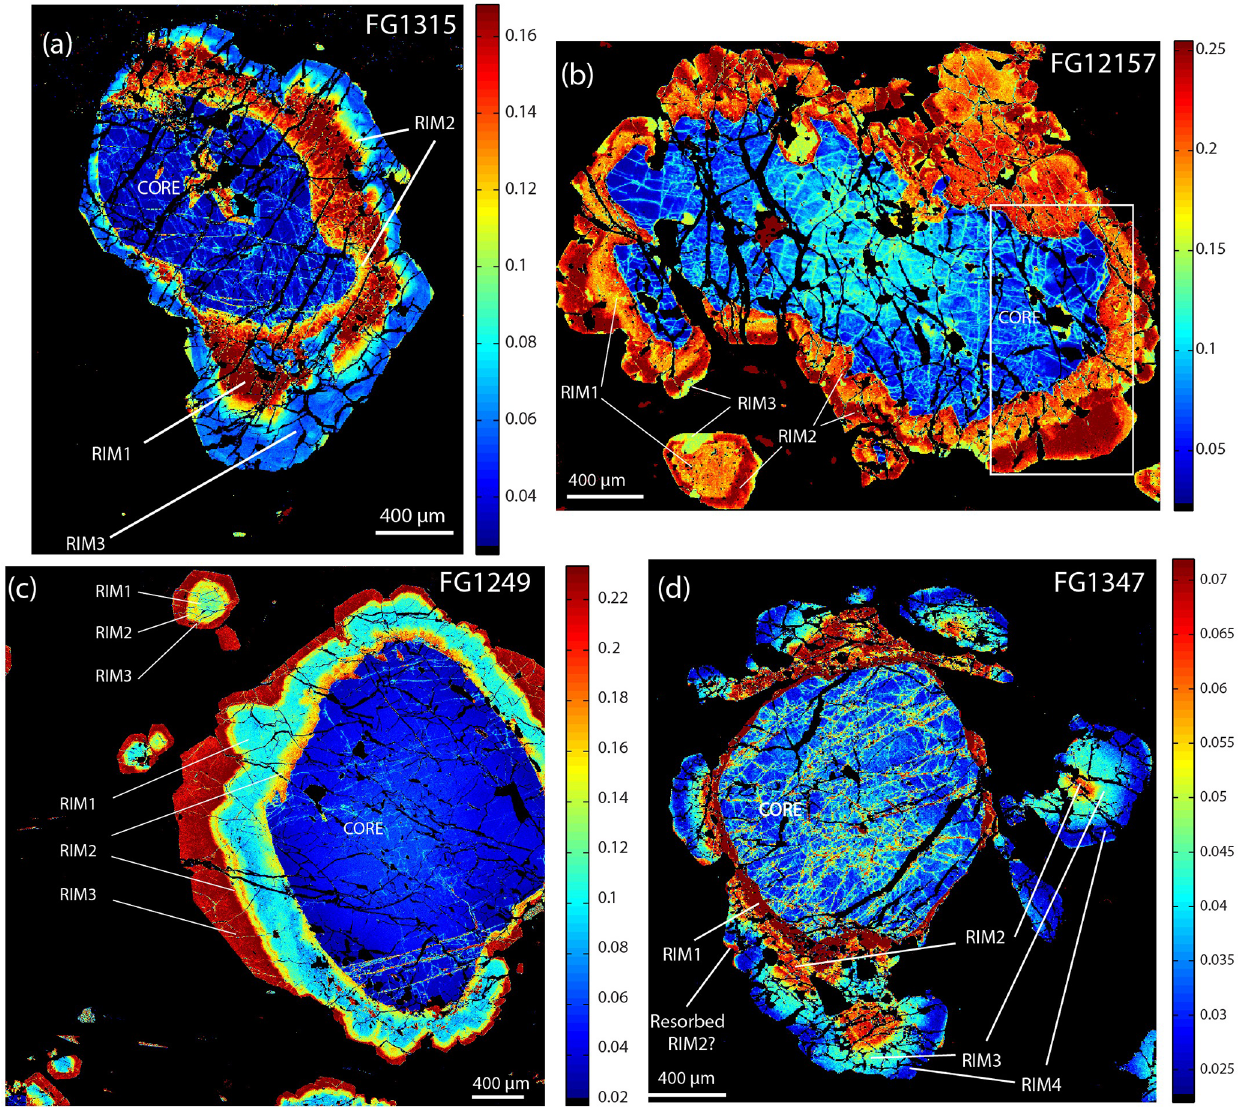
Figure 4. Growth zones visible in standardized X-ray maps for the grossular endmember. The foliation in all photos is horizontal. Note that a fractured core poor in X Grs is present in all samples and always rimmed by several garnet growth zones. In FG1315 (a) and FG12157 (b) textures indicating resorption include lobate edges and peninsulas (the white rectangle indicates the location of Fig. 3b–c). In FG1249 (c) resorption is inferred from the growth of Rim2 both inside and outside Rim1. In FG1347 (d) resorption is limited to the fractures in the core and Rim2 (see text); rims vary in thickness in each generation of